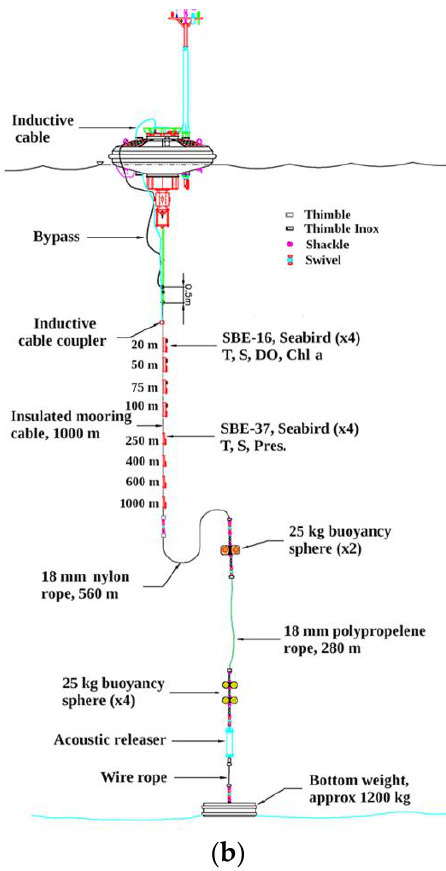
Figure 12. The multiparametric buoys of the Poseidon system ( a ). The mooring line diagram ( b ) corresponds to the E1M3A and PYLOS. The deployments depths of the sensors are 20, 50, 75, 100, 250, 400, 600 and 1000 m. The ATHOS buoy hosts sensor only for the first 100 m.